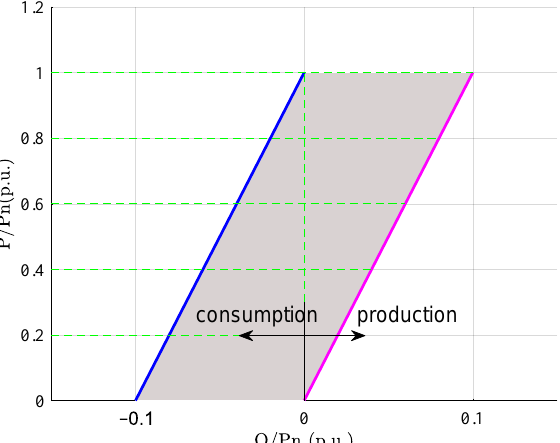
Figure 13. Basic requirements on the supply of reactive power from renewable plants according to Danish standards. The lines in blue and magenta are the minimum and maximum limits of reactive power variation in relation to active power variation, respectively.